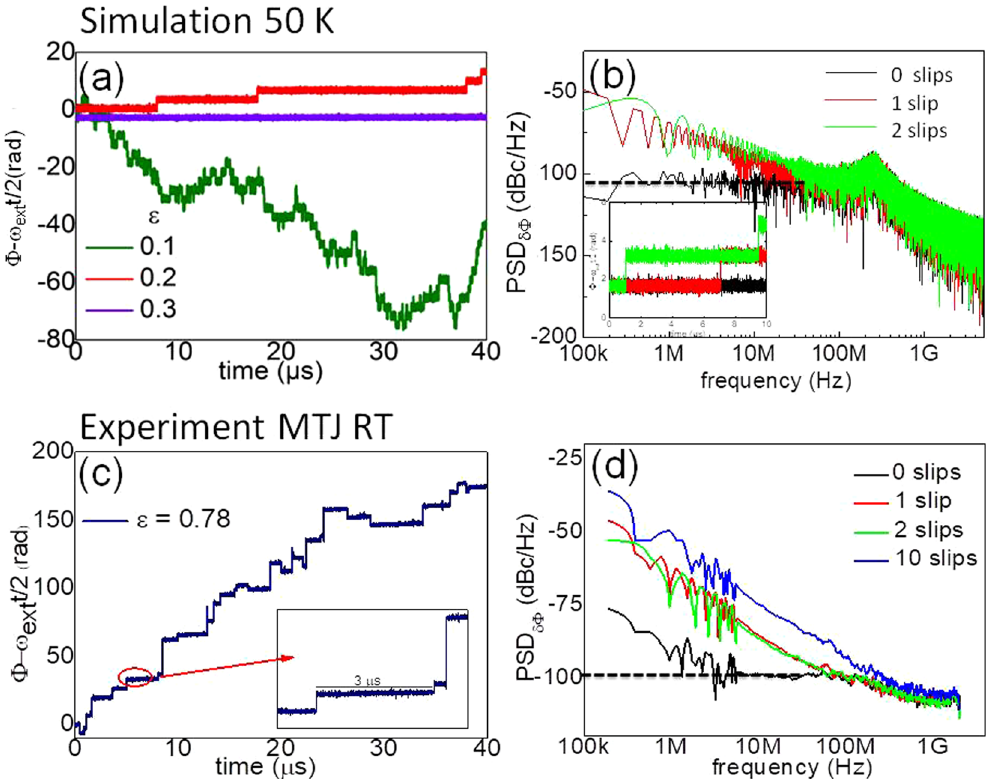
Figure 2. Simulated ( a ) and experimental ( c ) phase temporal traces. Inset: detail of 5 μ s segments of the temporal trace. The phase slips decrease in number with increasing ε disappearing at ε = 0.3. ( b ) Phase noise analysis on the simulated temporal trace segments (inset) corresponding to no phase slips (black), 1 phase slip (red) and 2 phase slips (green). ( d ) Phase noise analysis of the experimental time trace from 3 s segments with 0, 1, 2, 10 phase